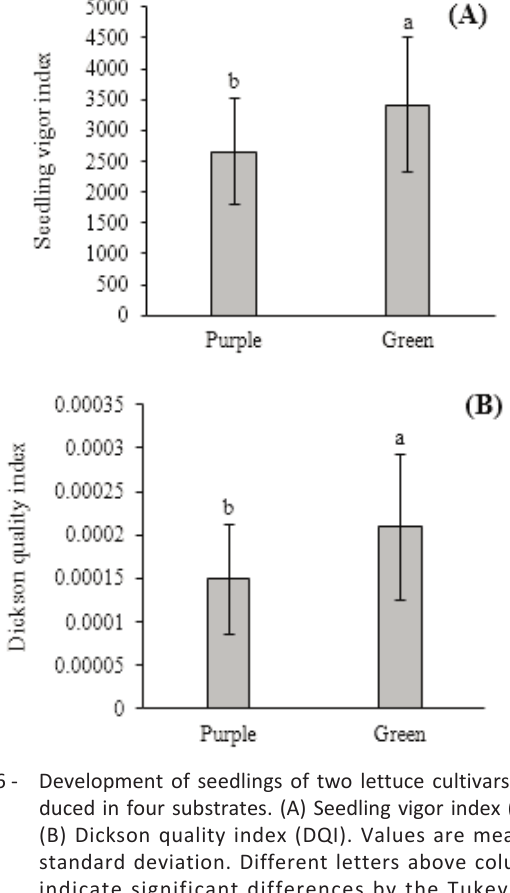
Fig. 6 - Development of seedlings of two lettuce cultivars pro- duced in four substrates. (A) Seedling vigor index (SVI); (B) Dickson quality index (DQI). Values are means ± standard deviation. Different letters above columns indicate significant differences by the Tukey test (P≤0.05, n = 3). Purple: Mimosa Roxa Salad Bowl culti- var; Green: Mônica SF 31